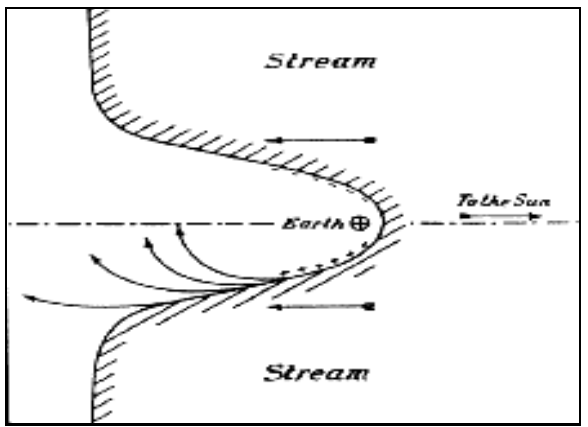
Figure 5. The formation of the Chapman–Ferraro cavity. Arrows indicate paths of ions and electrons that account for the ring cur- rent’s formation (Chapman and Ferraro,